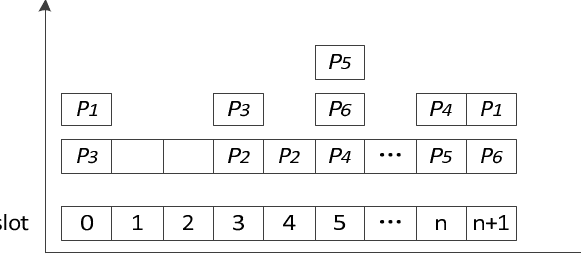
Figure 4. Contention resolution schematic.